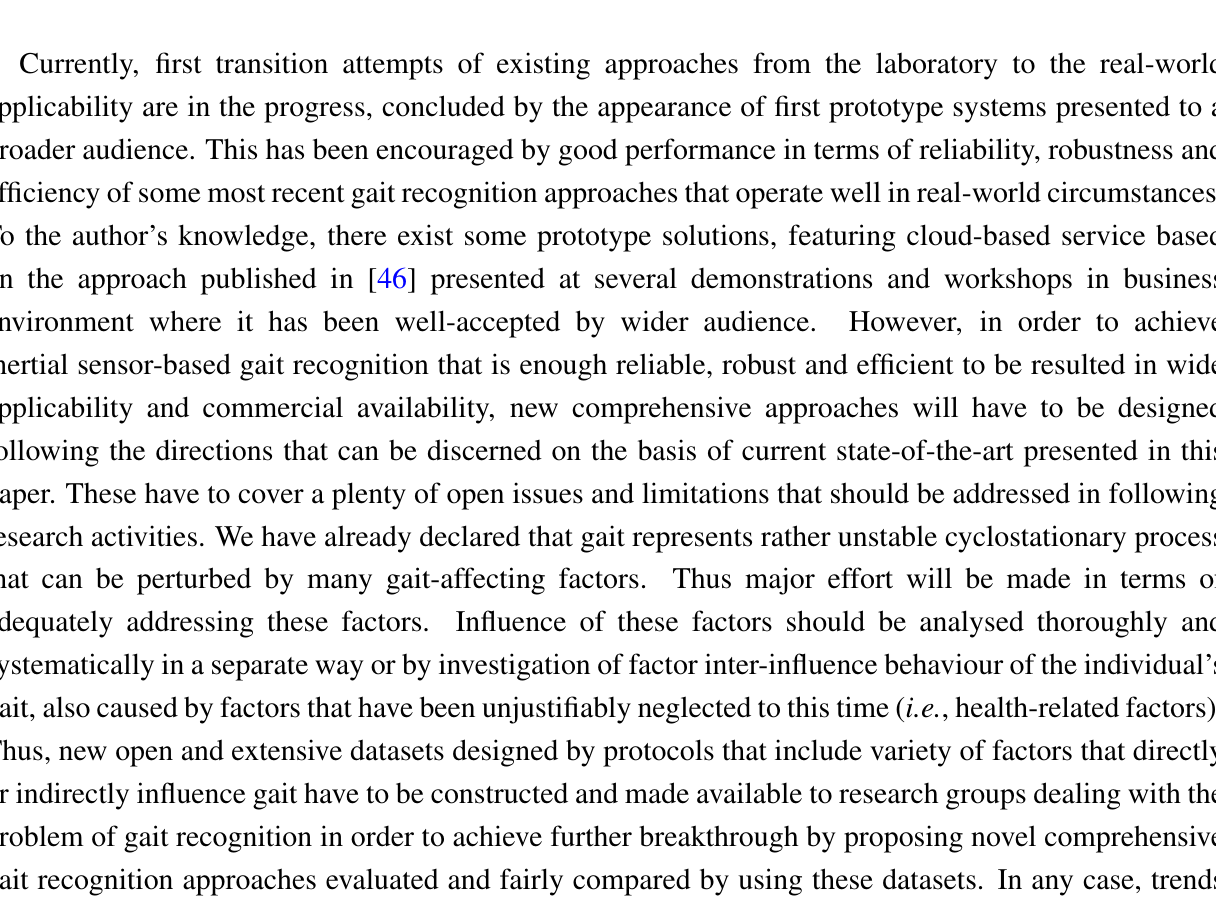
Figure 4. Number of papers in the area of inertial sensor-based gait recognition published in last decade (based on the references considered in review